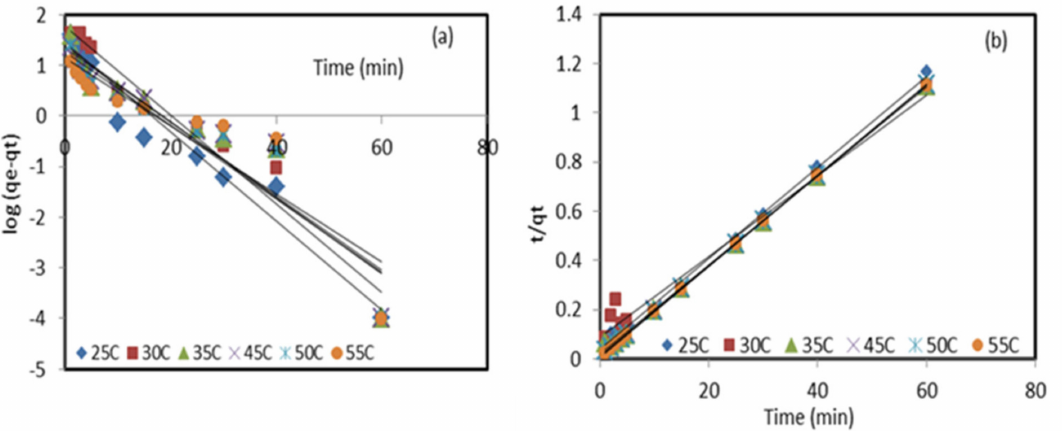
Figure 4. Pseudo-first-order ( a ) and pseudo-second-order ( b ) linear plots of Pb 2+ retention by the modified sorbent ZnO NP/DPF at different